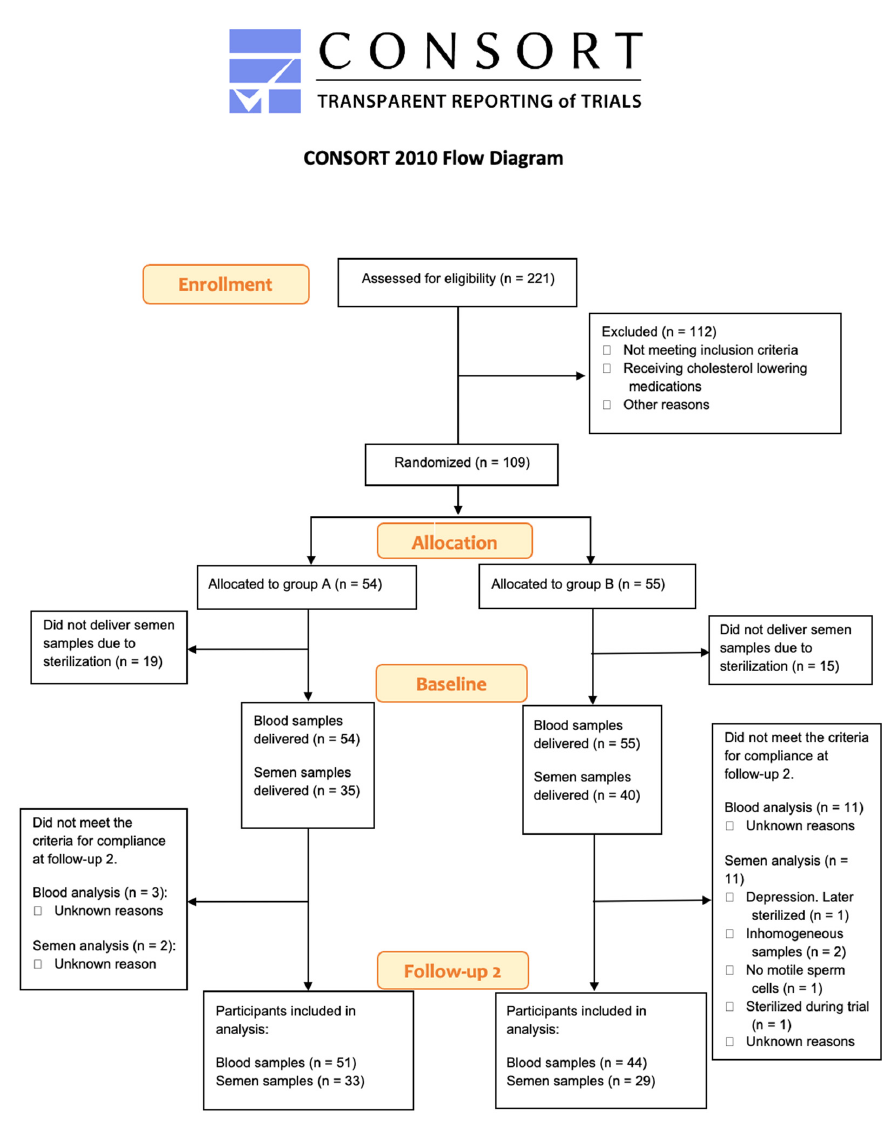
Figure 2. Consort 2010 Flow Chart [50]. Illustrating the flow of the study participants.